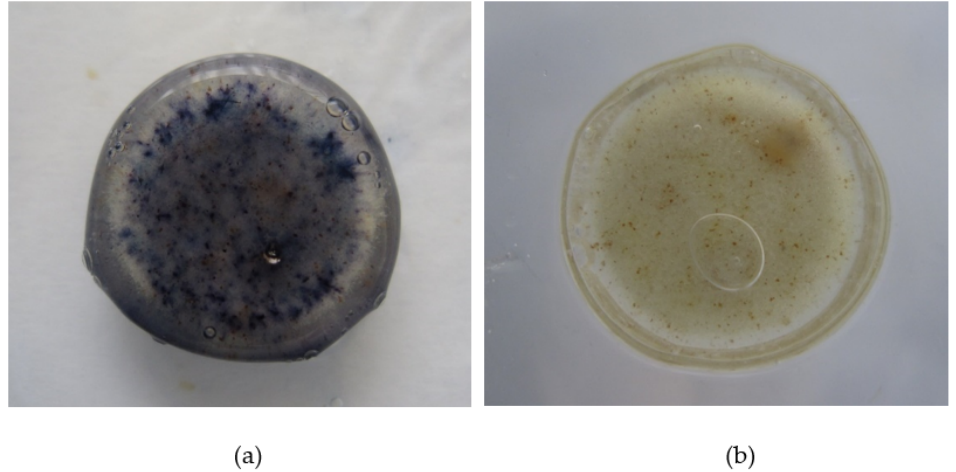
Figure 3. Concentration of fostemsavir and parent temsavir in hydrating ER tablets and dissolution media after 3 h and 7 h hydration.